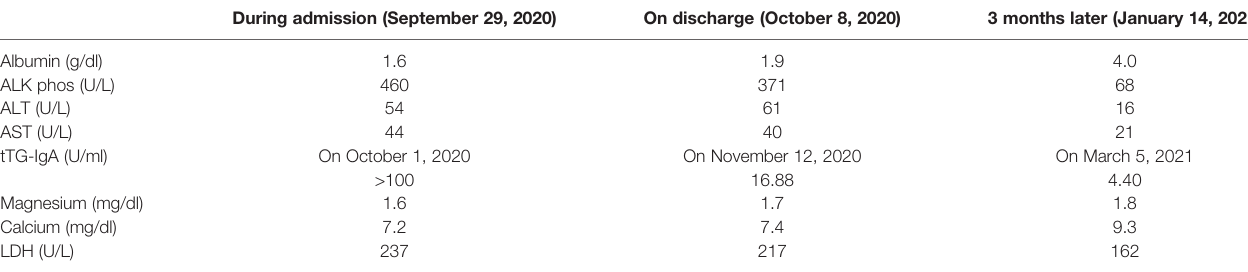
TABLE 1 | Lab values of interest on admission, discharge, and 3 months